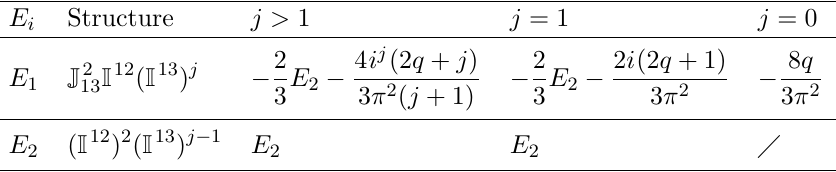
( QO ) SO when QO has h i